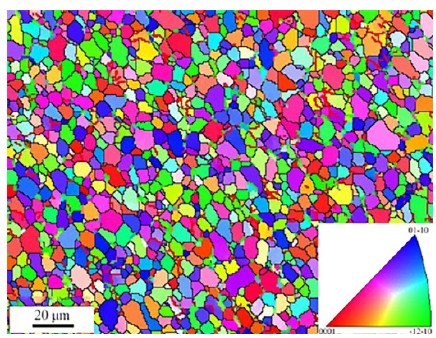
Figure 4. Cold-rolled structures of Ti-6Al-4V.